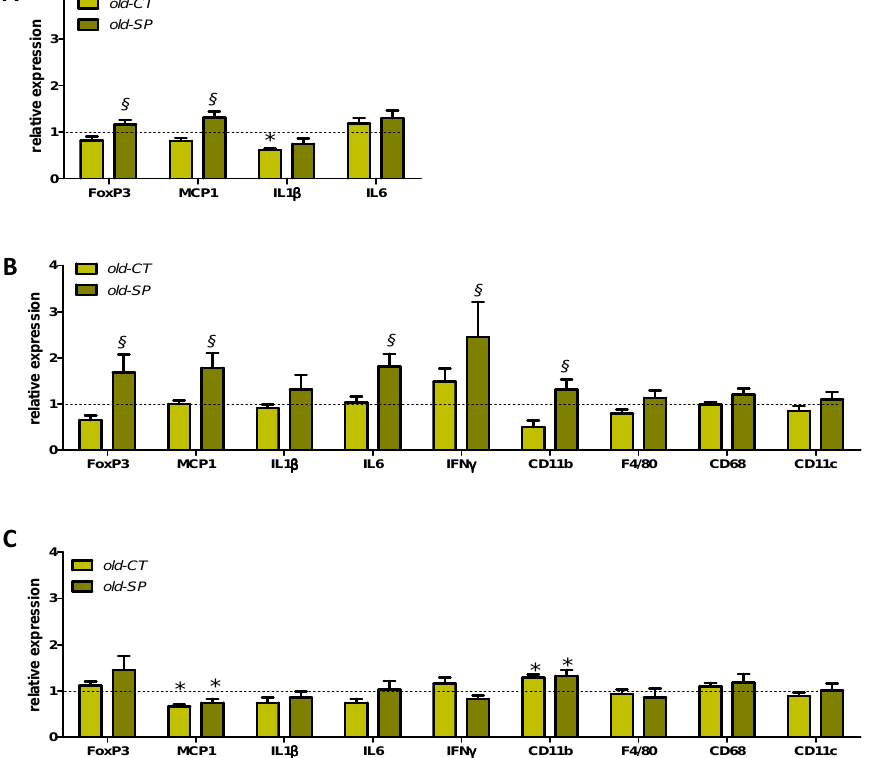
Figure 4. Expression of inflammatory markers in the jejunum ( A ), ileum ( B ), and colon ( C ). Old mice were fed a standard diet supplemented with or without Spirulina for six weeks and were compared to young mice fed a standard diet. Values are expressed as relative units with the mean of young mice values set at 1. * p < 0.05 versus young mice; § p < 0.05 versus old-CT mice (ANOVA). IFN γ , interferon gamma; IL, interleukin; MCP1, monocyte chemotactic